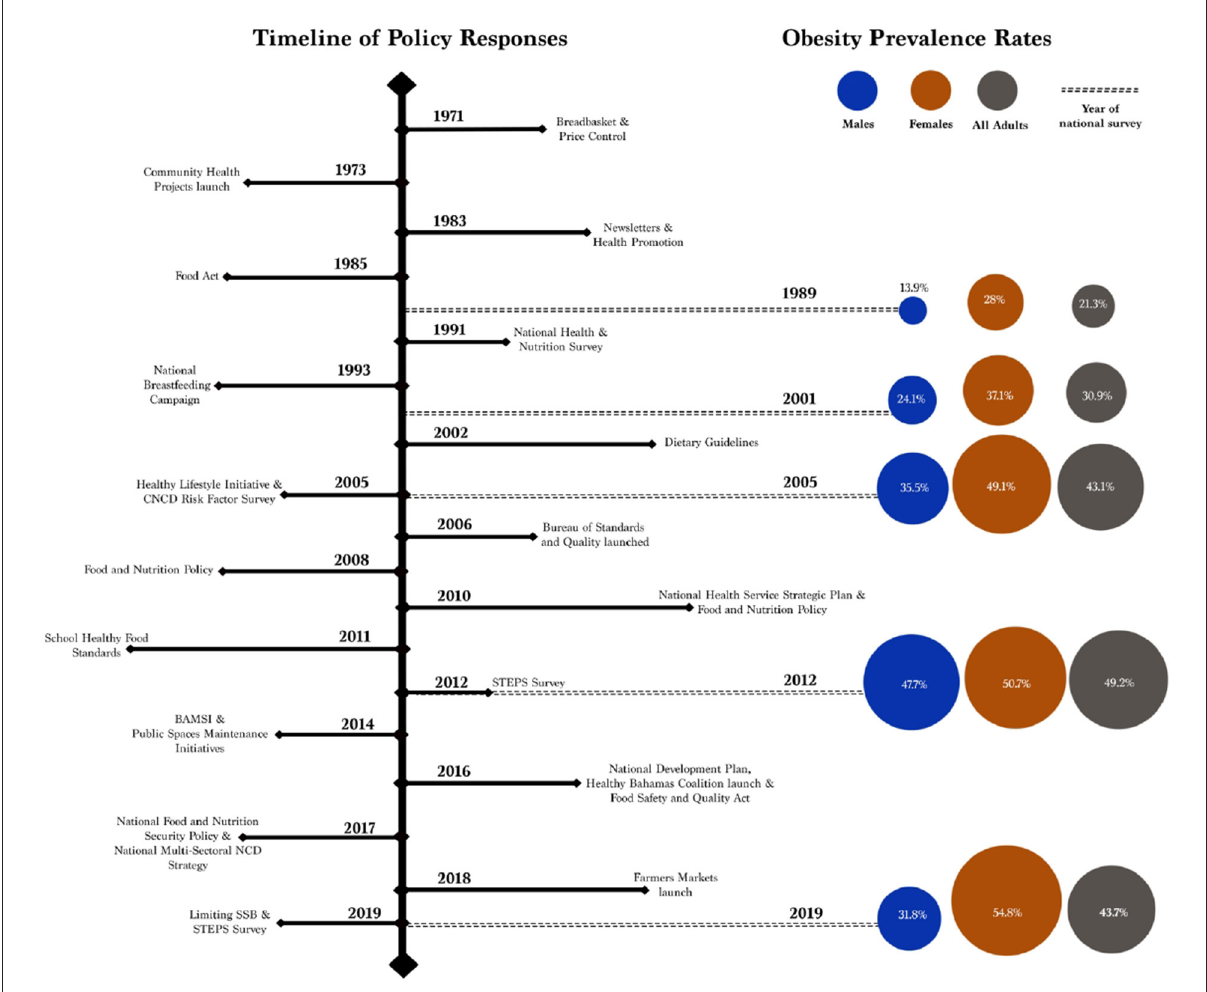
FIGURE5 Time of policy responses and obesity prevalence rates in The Bahamas between 1971 and 2019. The figure shows that policy responses may have led to a decrease in the prevalence of obesity between 2012 and 2019. There is, however, a gendered health disparity where the prevalence continued to increase in women during the period. This indicates to make additional progress, there is room for further interventions that consider the gender components that influence the prevalence of